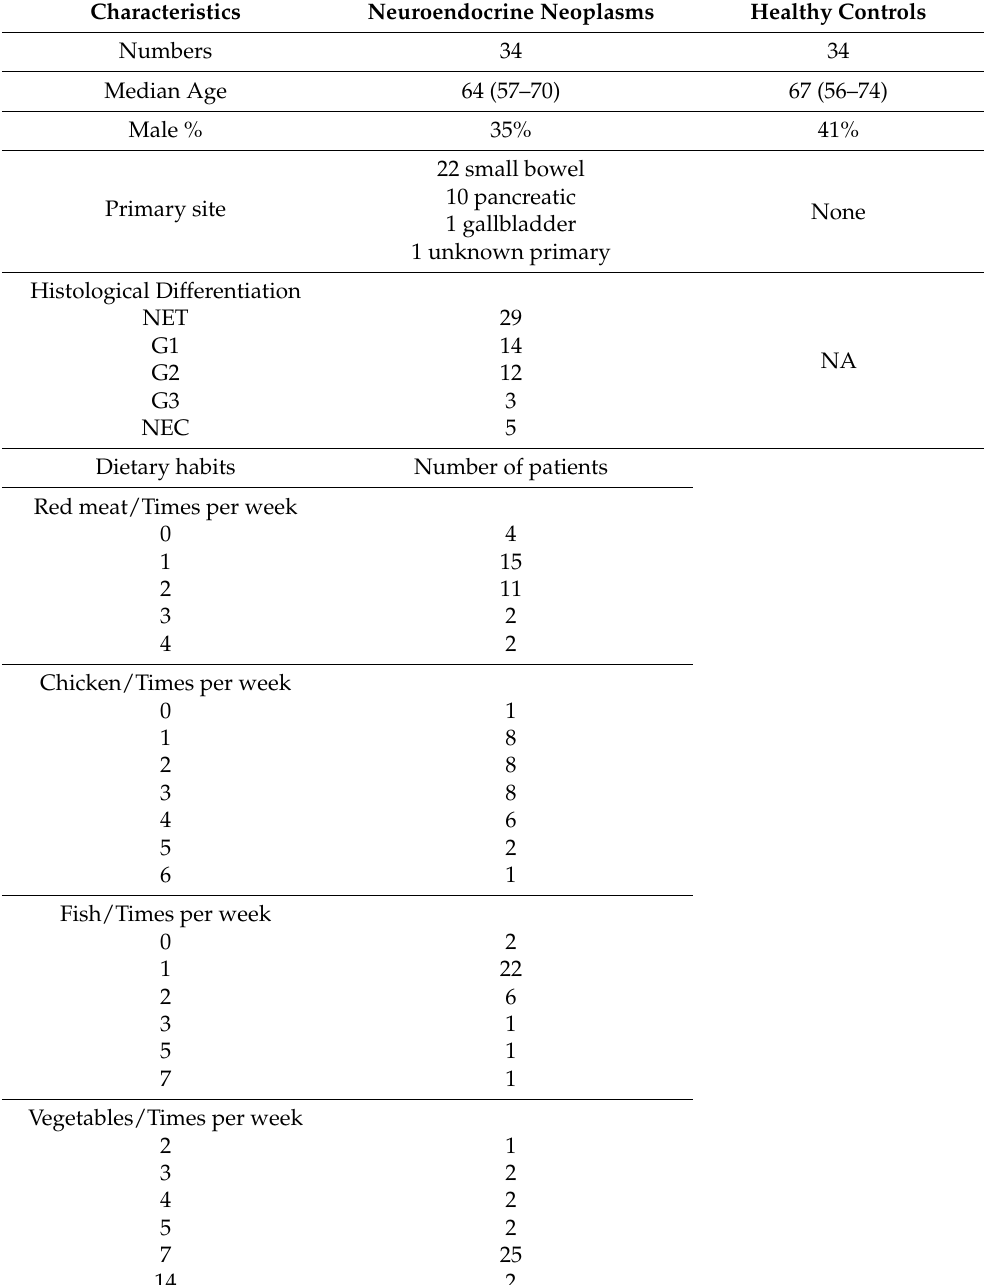
Table 1. Summary of